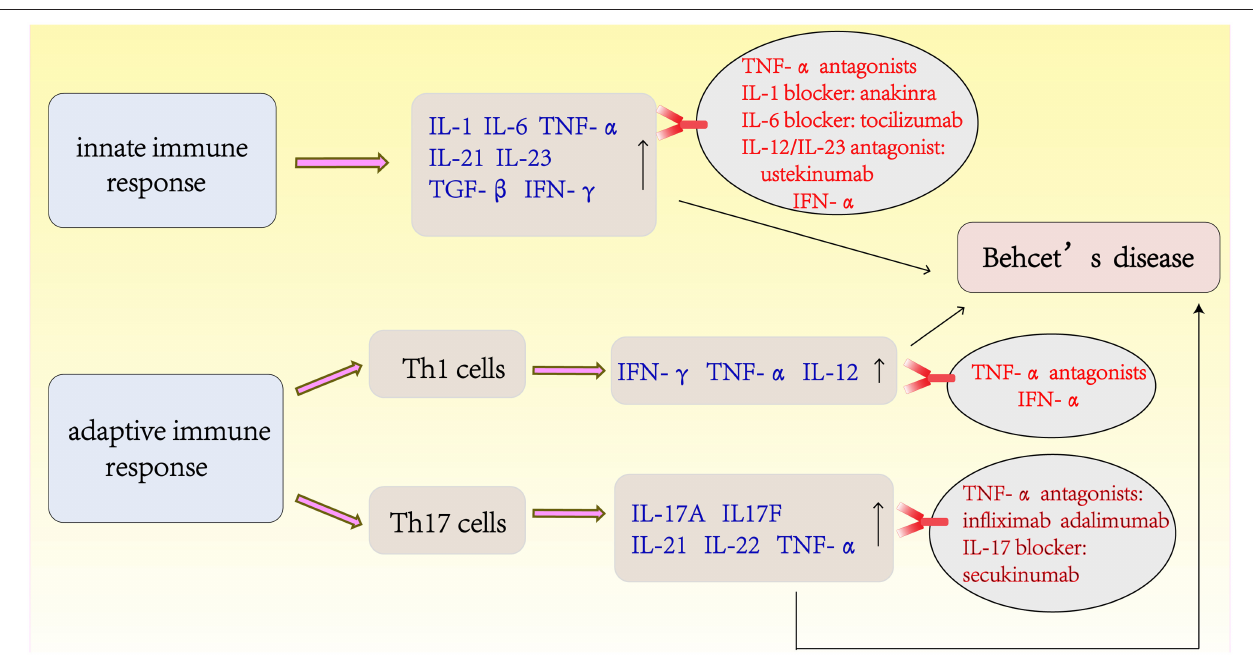
FIGURE 3 | The latest treatments of Behcet’s disease is based on the immunopathogenesis of